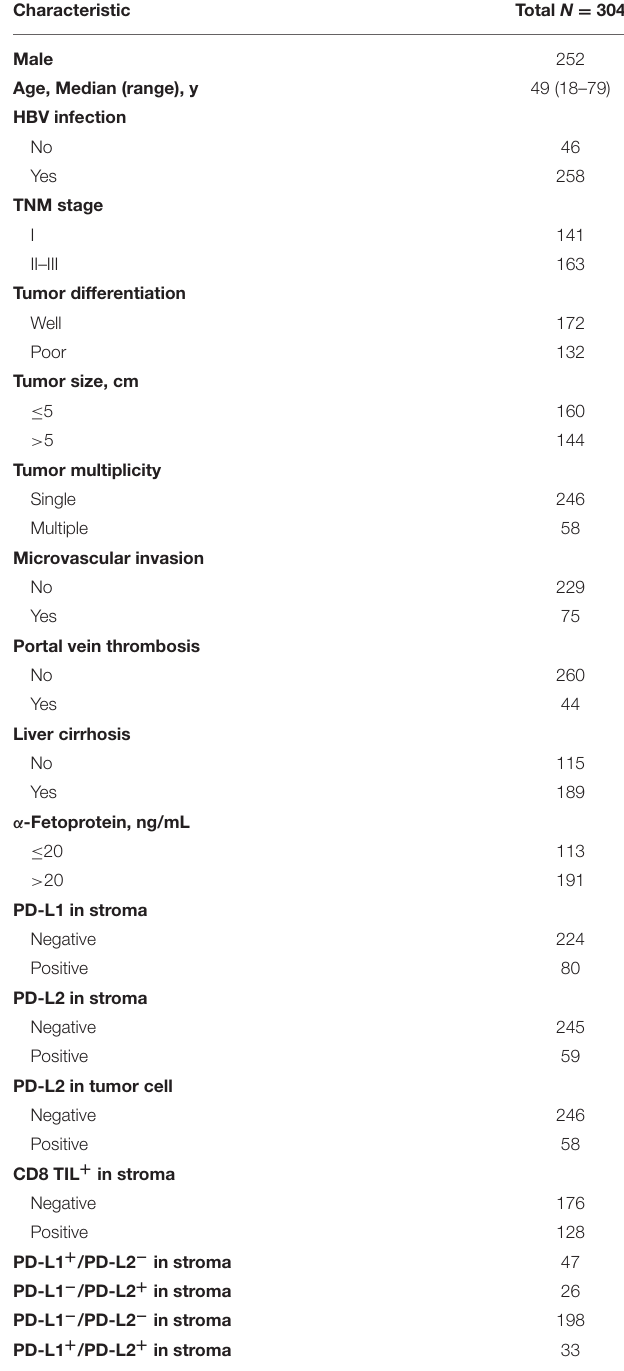
TABLE 1 | Baseline characteristics of HCC patients.